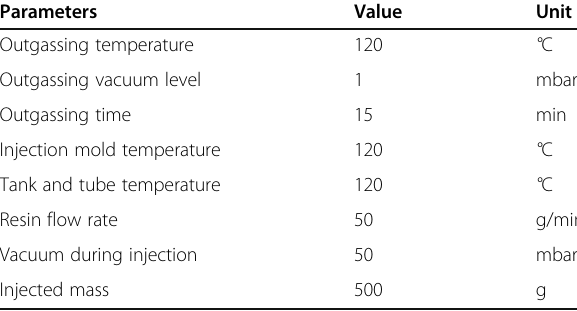
Table 2 LRI main process parameters